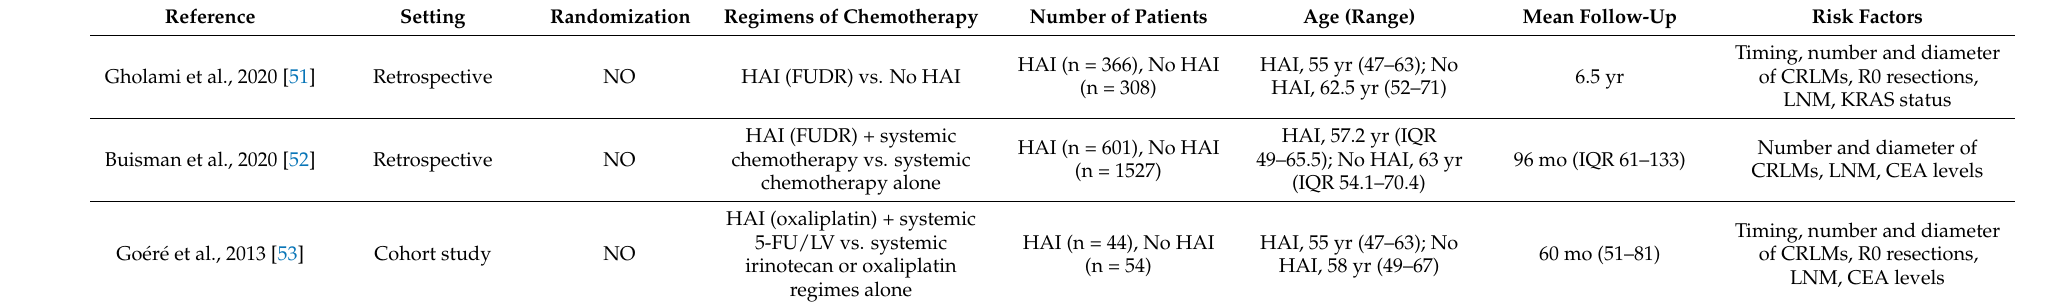
Table 2. Characteristics of patients in HAI chemotherapy